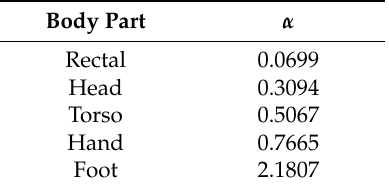
Table 3. Parameter α for different body